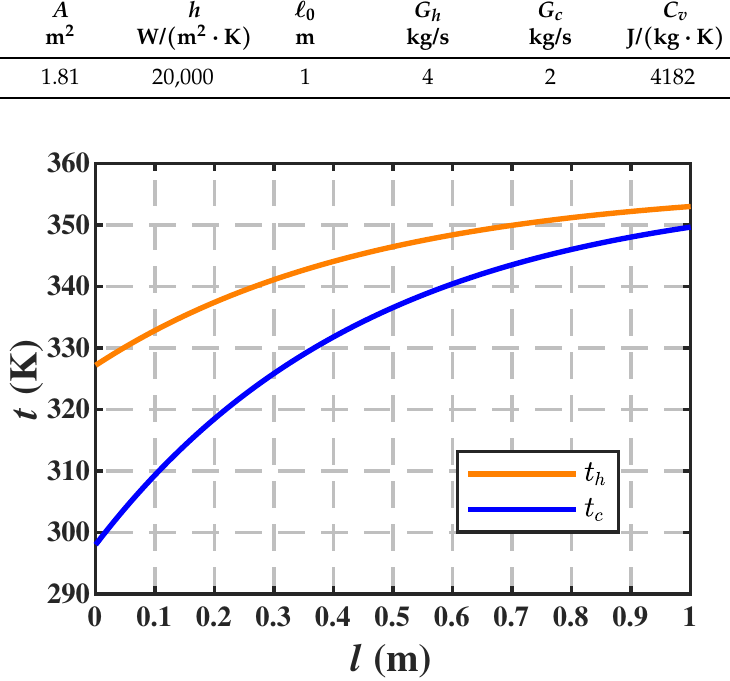
Figure 2. Temperature profiles of above demonstrated